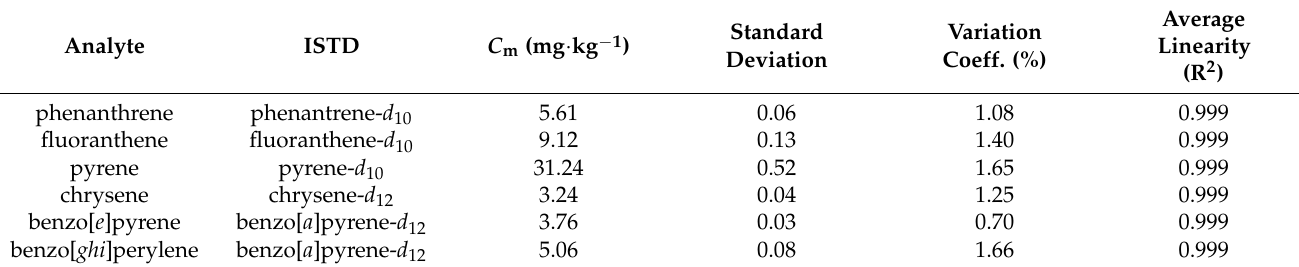
Table 4. Results of quantitative GC/MS